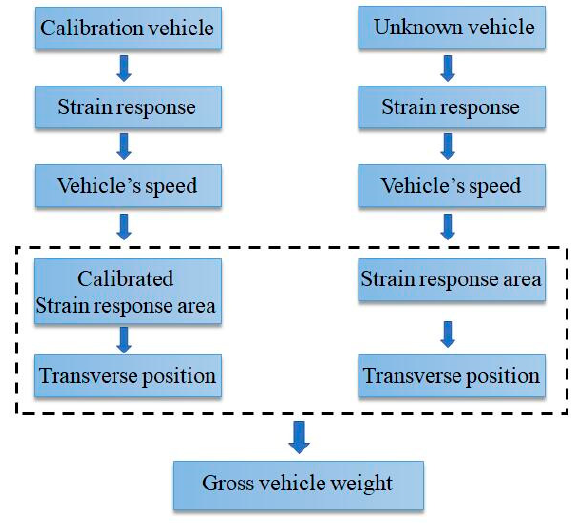
Figure 1. The whole flowchart of the identification method.